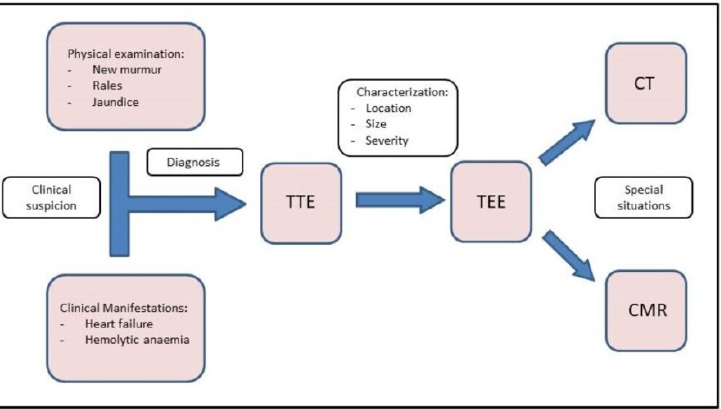
Figure 1. Central Illustration. Diagnostic flow chart. Diagnosis starts with clinical suspicion. TTE and TEE should be performed to confirm the diagnosis and correct characterization. Finally, CMR and CT can be used in special situations.